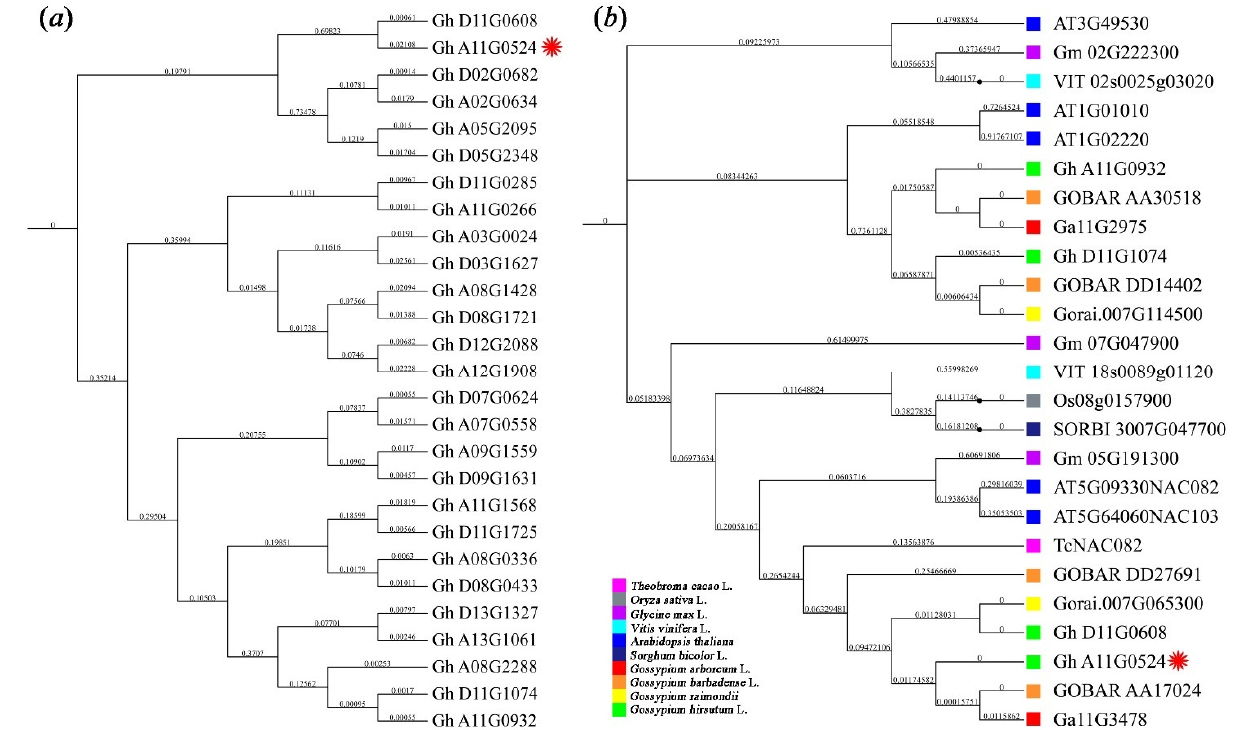
Figure 1. Evolution of GhNAC82 in upland cotton ( a ) and other species ( b ). red * indicated the GhNAC82 gene.